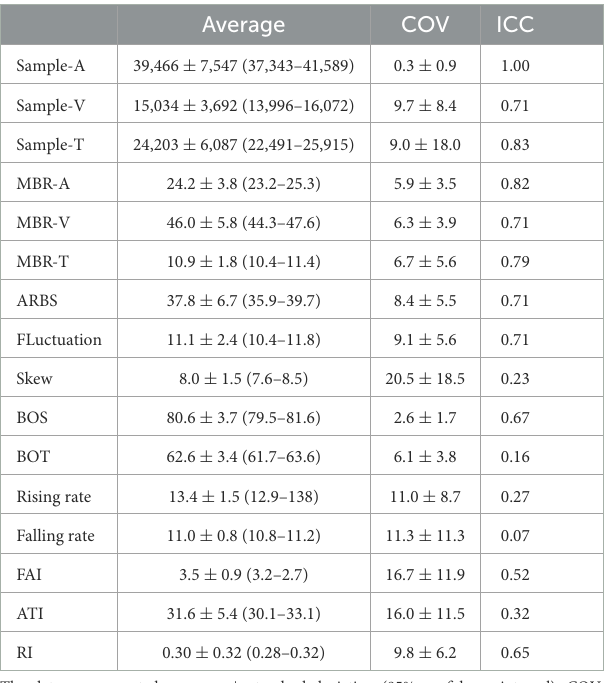
TABLE 4 Coefficient of variation and intraclass correlation coefficient for blood flow values, number of sample, ARBS, and wave form parameters in the optical nerve